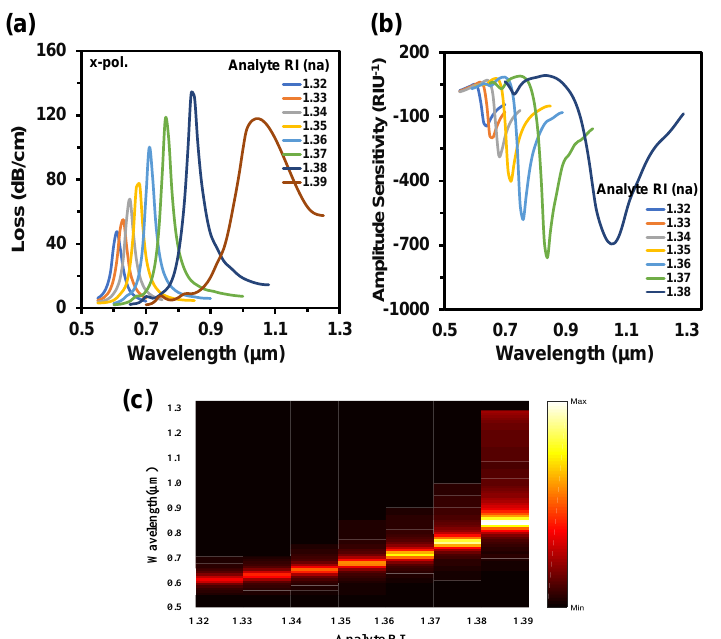
Figure 7. ( a ) CL spectrum while the same analyte RI is infiltrated in both channels, ( b ) AS for the variation of analyte RI from 1.33 to 1.38, and ( c ) normalized 2D map of CL intensity when the same analyte RIs are used in both channels.